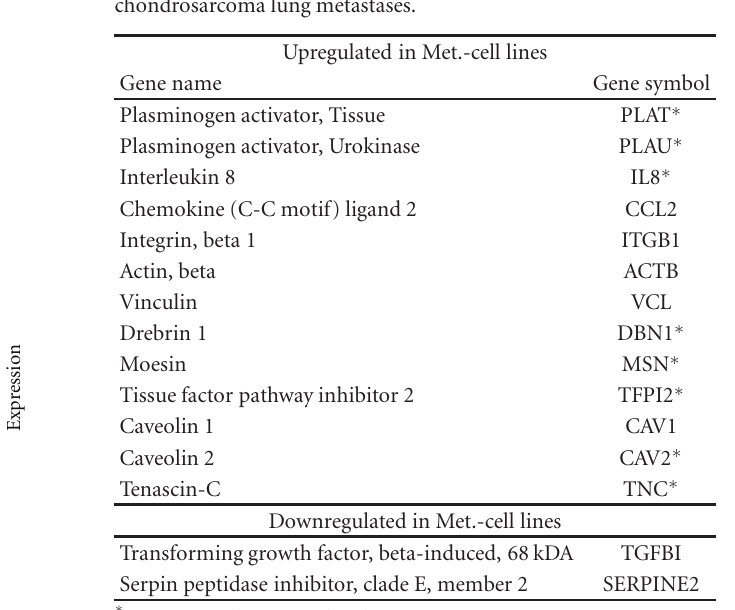
Table 2: “Biased multifunctional signature” of dedi ff erentiated chondrosarcoma lung